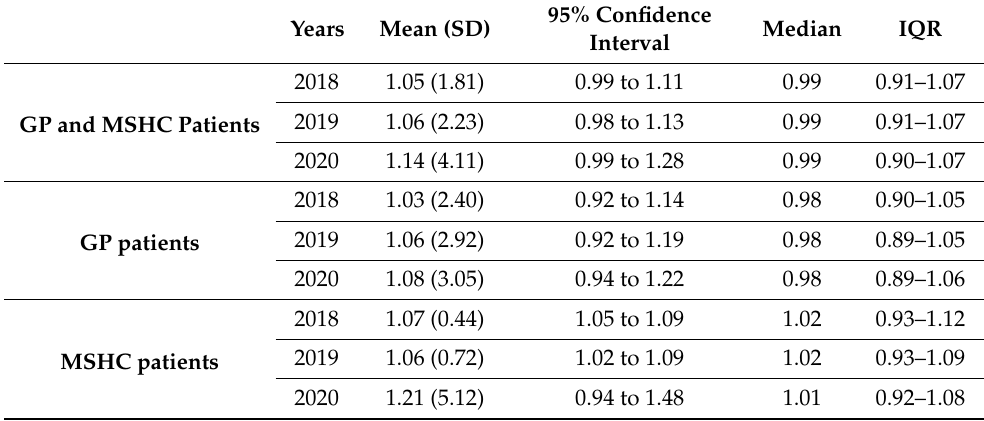
Table 1. Medication Possession